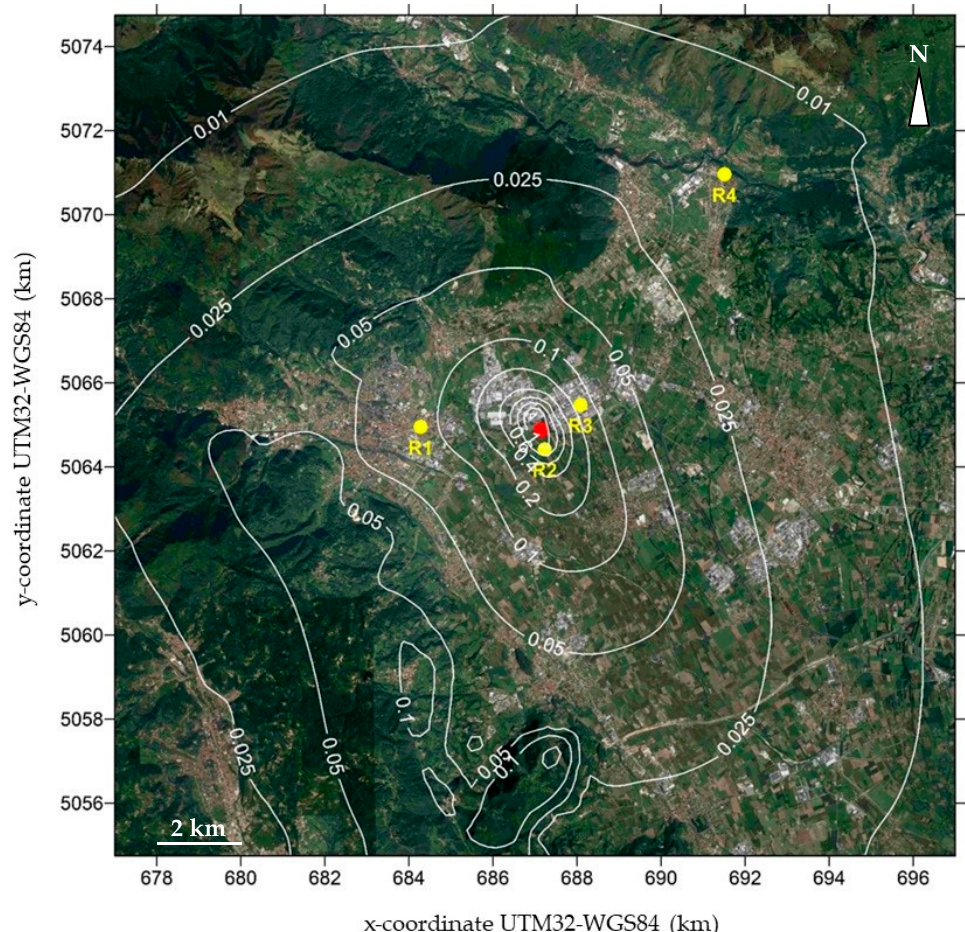
Figure 4. Spatial distribution of NO 2 annual mean concentration ( µ g m − 3 ) estimated as contribution of plant emissions to ambient levels.